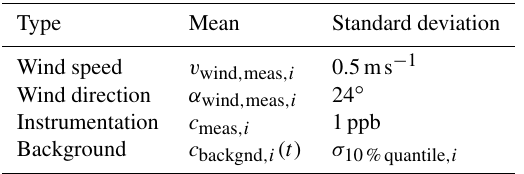
Table 1. Mean and standard deviation of the input parameters for the CH 4 plume signal i .